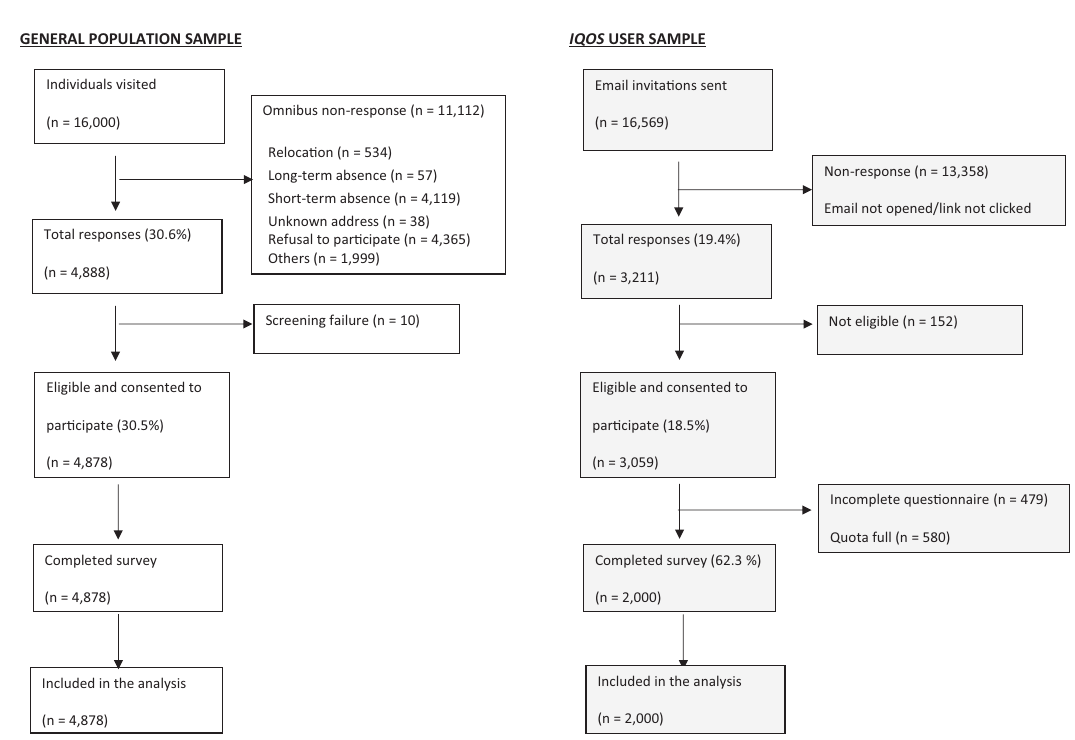
Figure 1. Flow diagram of study sample composition and response